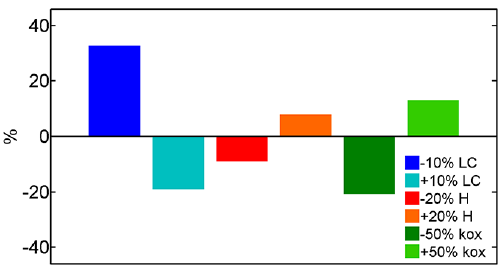
Figure 14. Variations in NEM for parameters leading to a change exceeding 5% of its reference value (see Fig.